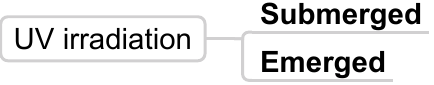
Figure 6. Partial taxonomy: UV